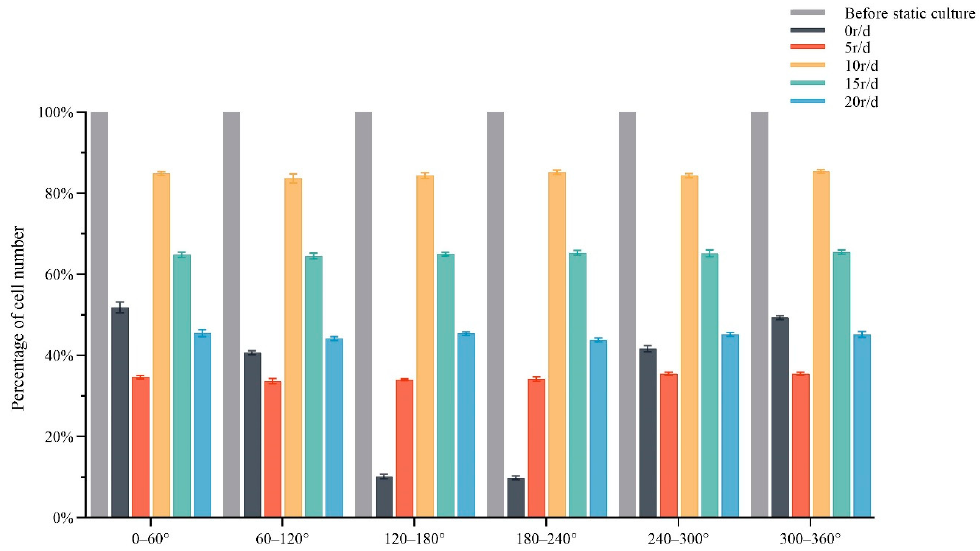
Figure 7. Polar plots of cell distribution. Each blue circle represents a cell. The values of 0, 60, 120, 180, 240, and 300 represent the angles starting counterclockwise from directly above the annular film. The value of 0.5 represents the slit where the film was cut, and almost all cells were placed within 5 mm around the slit; 5 mm to the left represents 0; and 5 mm to the right represents 1. ( A ): The number of cells before the static culture after the cells were placed around the cell culture membrane. ( B ): The number of cells in each sector after the static culture for 5 days at a rotation speed of 0 r/d. ( C ): The number of cells in each sector after the static culture for 5 days at a speed of 5 r/d. ( D ): The number of cells in each sector after the static culture for 5 days at a speed of 10 r/d. ( E ): The number of cells in each sector after the static culture for 5 days at a speed of 15 r/d. ( F ): The number of cells in each sector after the static culture for 5 days at a speed of 20 r/d.